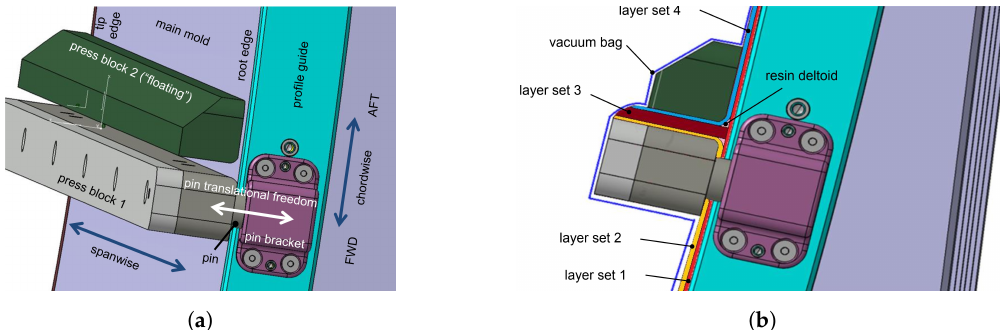
Figure 8. Manufacture concept for a single integral stringer. ( a ) 3D conceptual diagram of tooling; ( b ) side view showing different layer sets comprising skin and stringer.